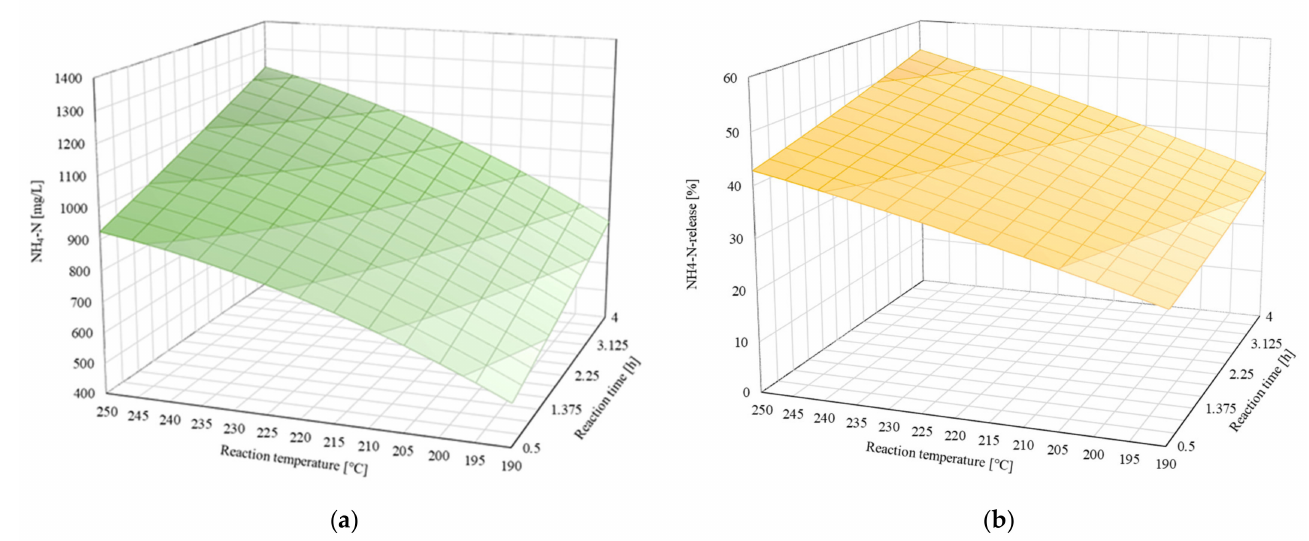
Figure 3. Response surface plots for ( a ) NH 4 -N at pH = 6.1 and ( b ) NH 4 -N release at pH =